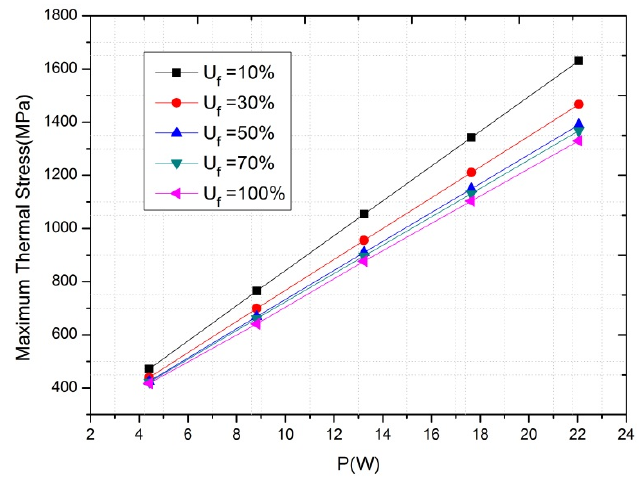
Figure 10. The effect of heating power on the thermal stress of TEG.